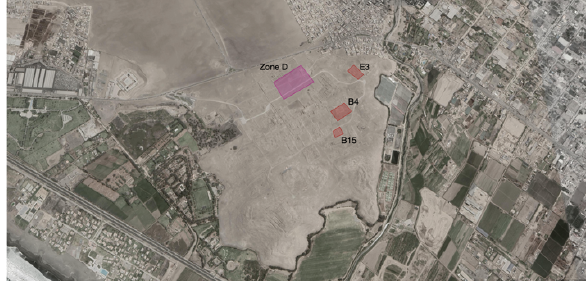
Figure 4 . Location of survey areas lower altitudes (© Google Maps 2021)